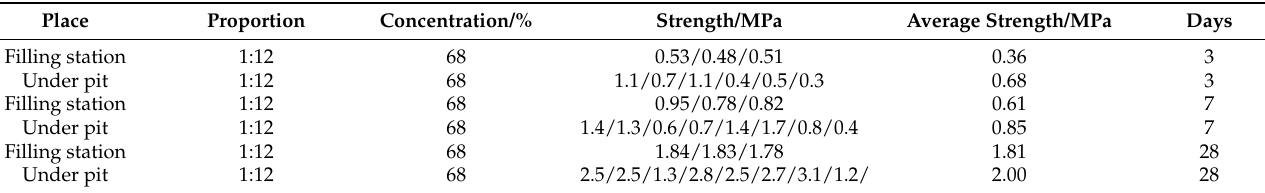
Figure 21. Downhole test block maintenance. Table 8. Comparison of subsurface maintenance